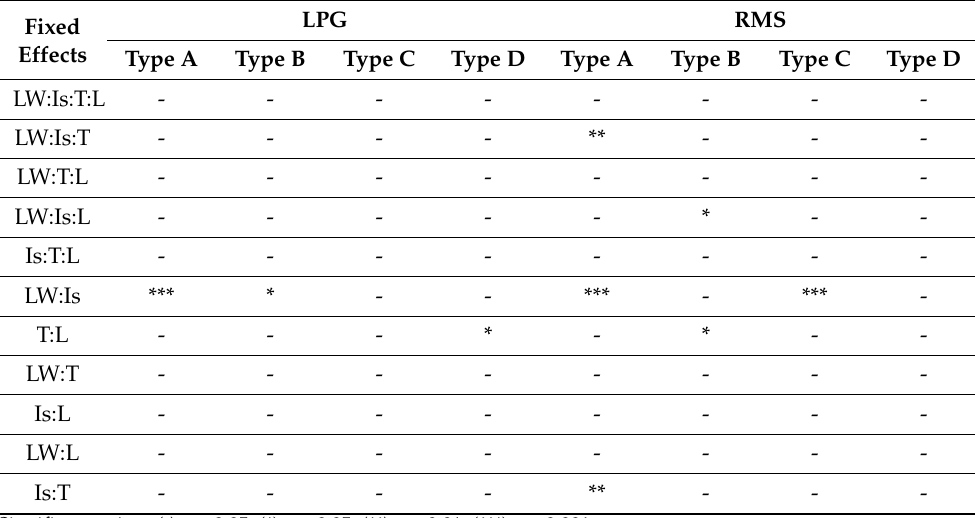
Table 3. Results of significance tests for interactions between car’s initial speed, road’s lane